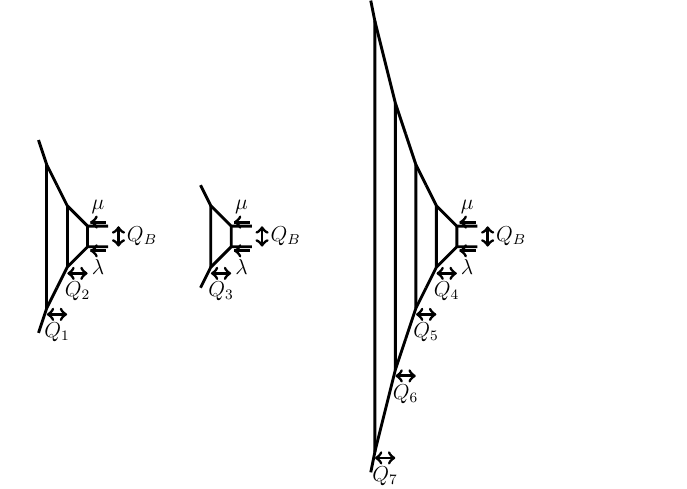
Figure 14 . The assignment of the K(cid:127)ahler parameters to the web in (cid:12)gure 13. We write the three webs separately for